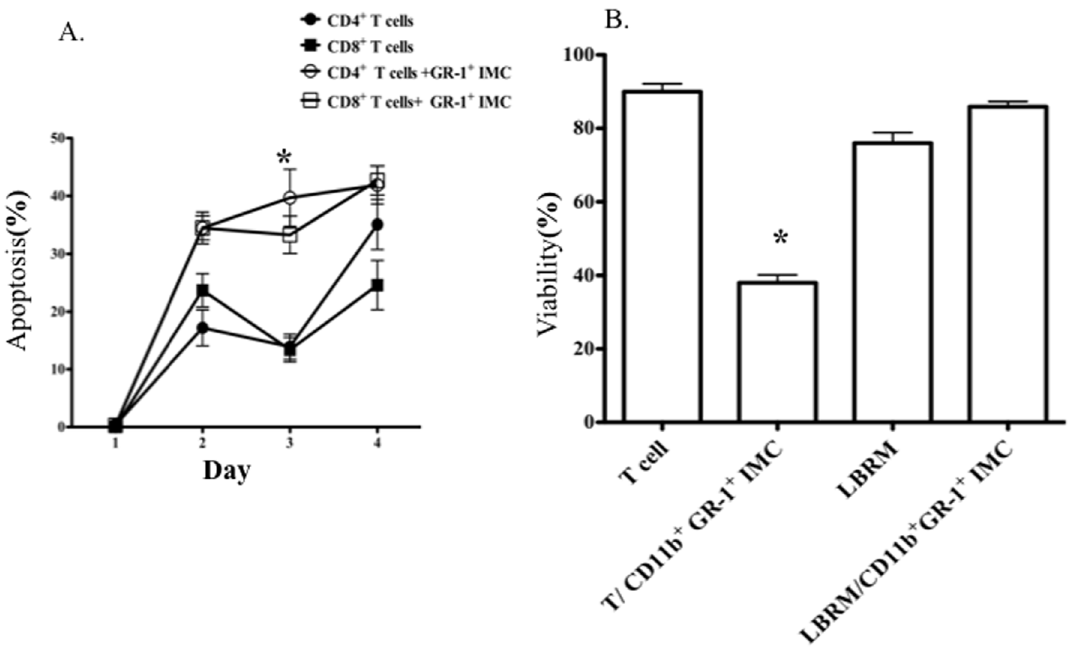
Figure 4. Co culture of Dynabead activated T-cells with CD11b + GR-1 + IMC induced T-cell apoptosis. Left panel: frequencies of 7-AAD ( + )/Annexin V ( + ) CD4 + and CD8 + T-cells cultured in the absence (filled symbols) or presence of CD11b + GR-1 + IMCs (empty symbols), as determined by flow cytometry. Right panel: Viability of T-cells and the T-cell lymphoblastic cell line, LBRM, cultured in the presence and absence of CD11b + sorted IMCs Trypan blue staining was performed after 4 days of culture ( p =0.0088). Data represent of mean values ( 6 SD) of three